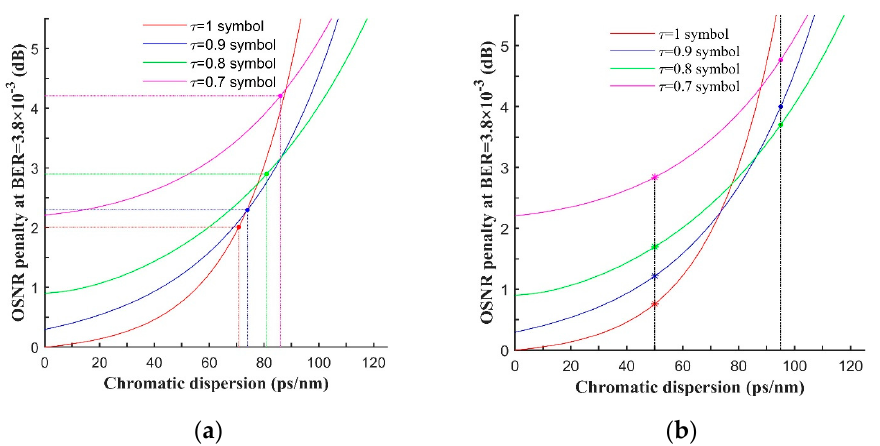
Figure 8. Measured OSNR penalty versus the chromatic dispersion at BER = 3.8 × 10 − 3 : ( a ) the dispersion tolerance due to the 2 dB OSNR penalty of the receiver, and ( b ) the OSNR penalty required for receivers with different delays to maintain a BER of 3.8 × 10 − 3 under the same system dispersion.